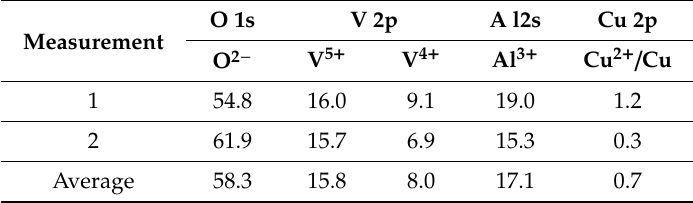
Table 2. The contribution of fitted peaks for vanadium-containing film on the Al 2 Cu